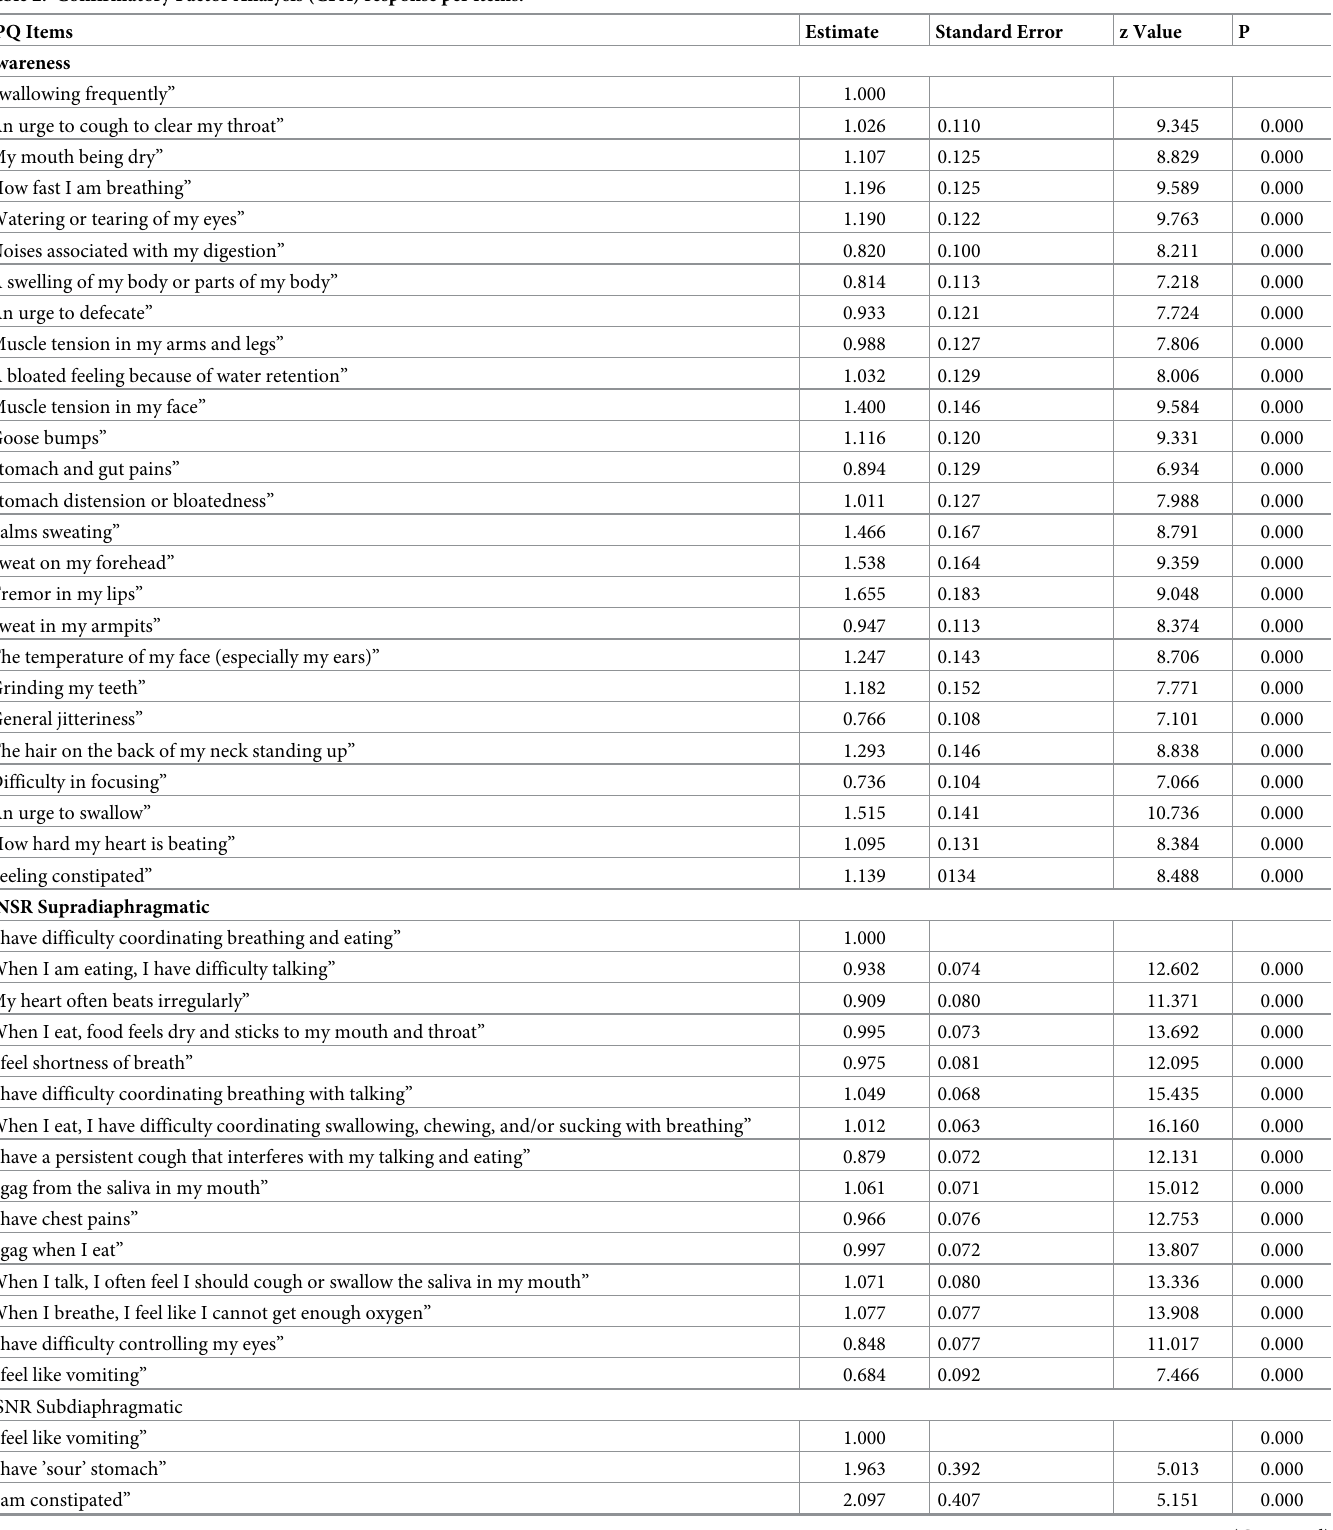
Table 2. Confirmatory Factor Analysis (CFA) response per